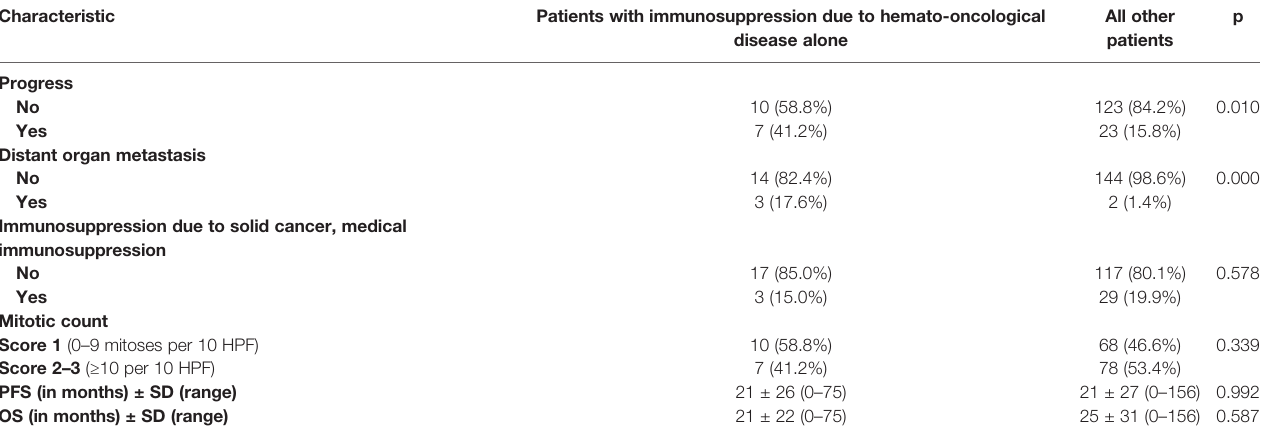
TABLE 2 | Correlation of immunosuppression due to a hemato-oncological disease and progress or distant organ metastasis. Characteristic